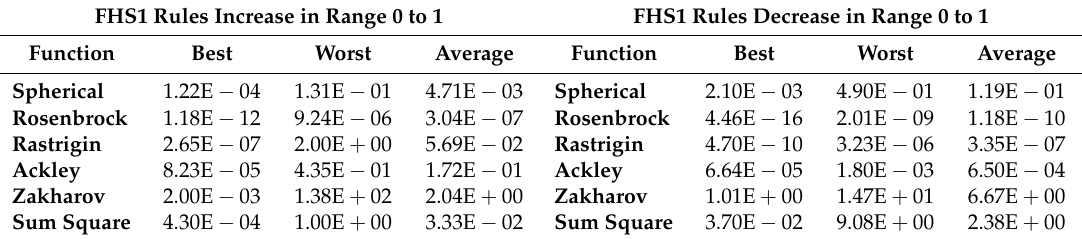
Table 3. Comparison of results obtained with the FHS1 using fuzzy logic to increase and decrease of the HMR parameter in the range 0 to 1.